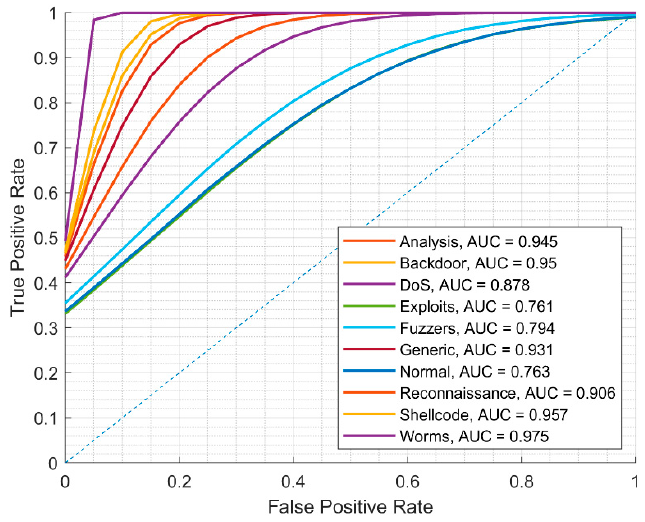
Figure 7. ROC curve of detected attacks using ML.NET created model on UNSW-NB15 training dataset.